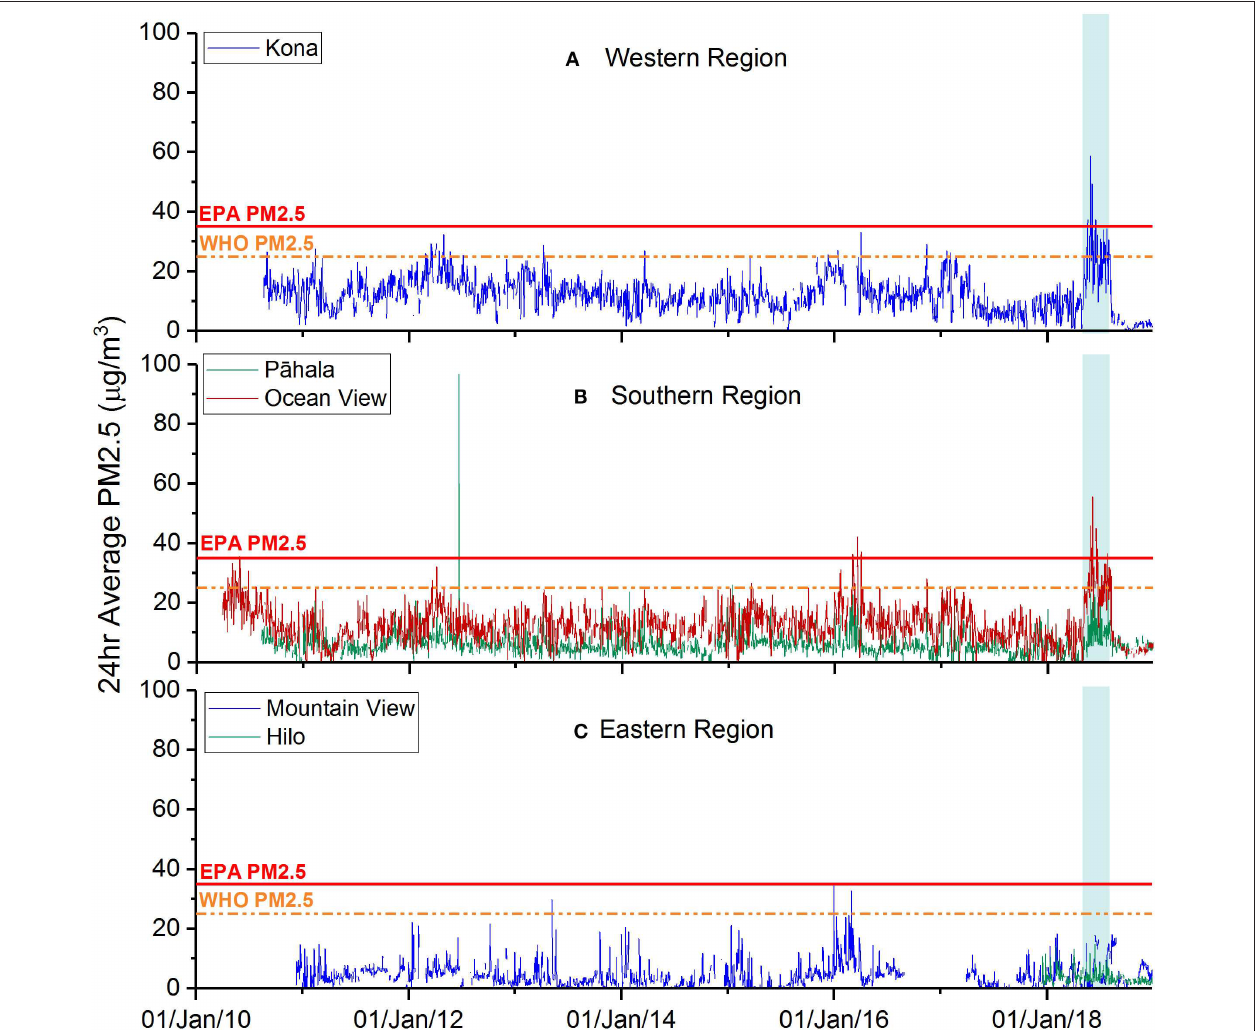
FIGURE 3 | PM 2.5 mass concentrations relative to health guidelines in select populated areas of Island of Hawai’i. (A–C) Concentrations of PM 2.5 (24-h mean) in populated areas from 2010 to the end of 2018. Solid red line: EPA Federal Standard air quality threshold (24-h mean of 35 µ g/m 3 ); dashed orange line: World Health Organization (WHO) air quality guideline (24-h mean of 25 µ g/m 3 ); blue highlight: 2018 LERZ eruption